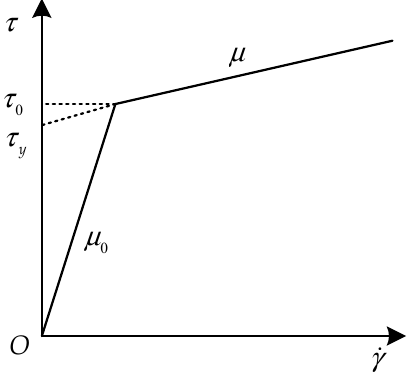
Figure 3. Bi-viscous rheological model.